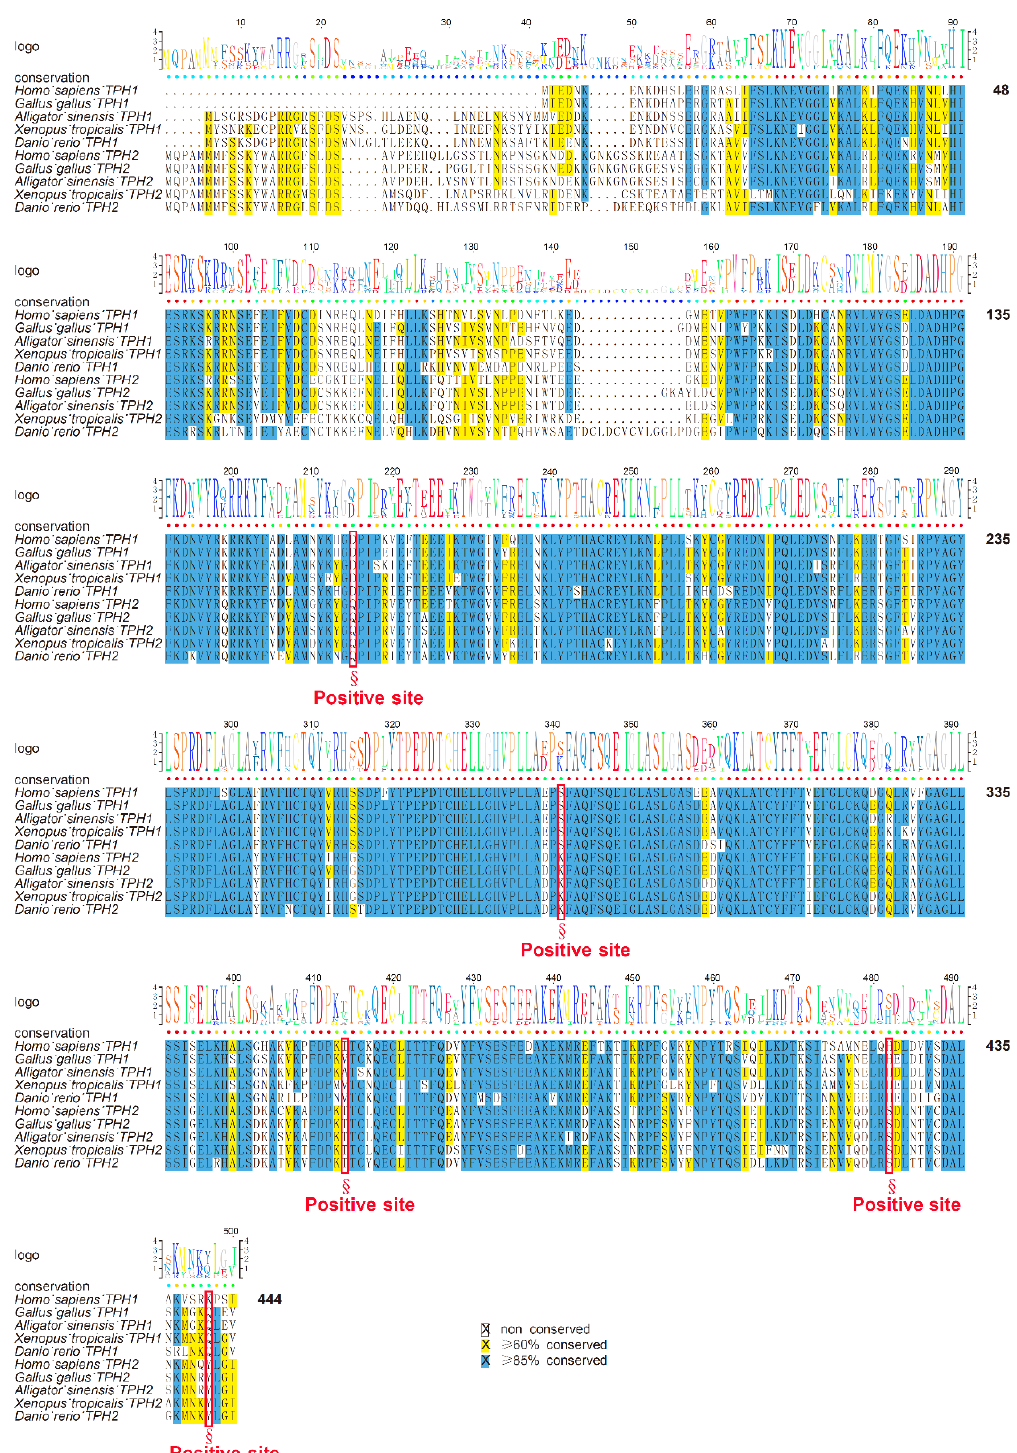
Figure 7. Alignment of the datasets for selection pressure analysis. The five positively selected sites predicted by the branch-site model test are marked with red boxes and emphasized with section marks (§).